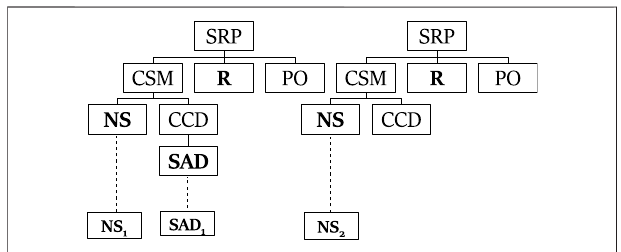
FIGURE 4 | An explanation created by PHATT for the ROSA